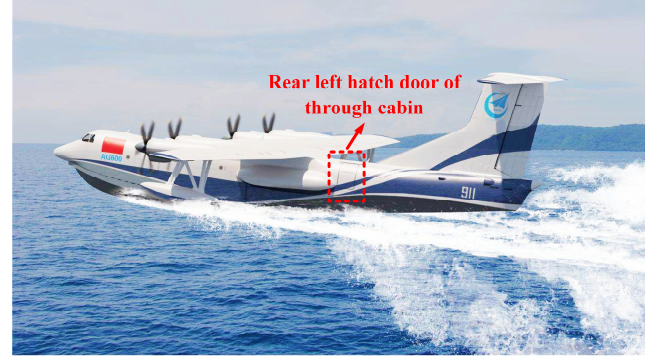
Figure 1. Amphibious aircraft take off from the water’s surface.